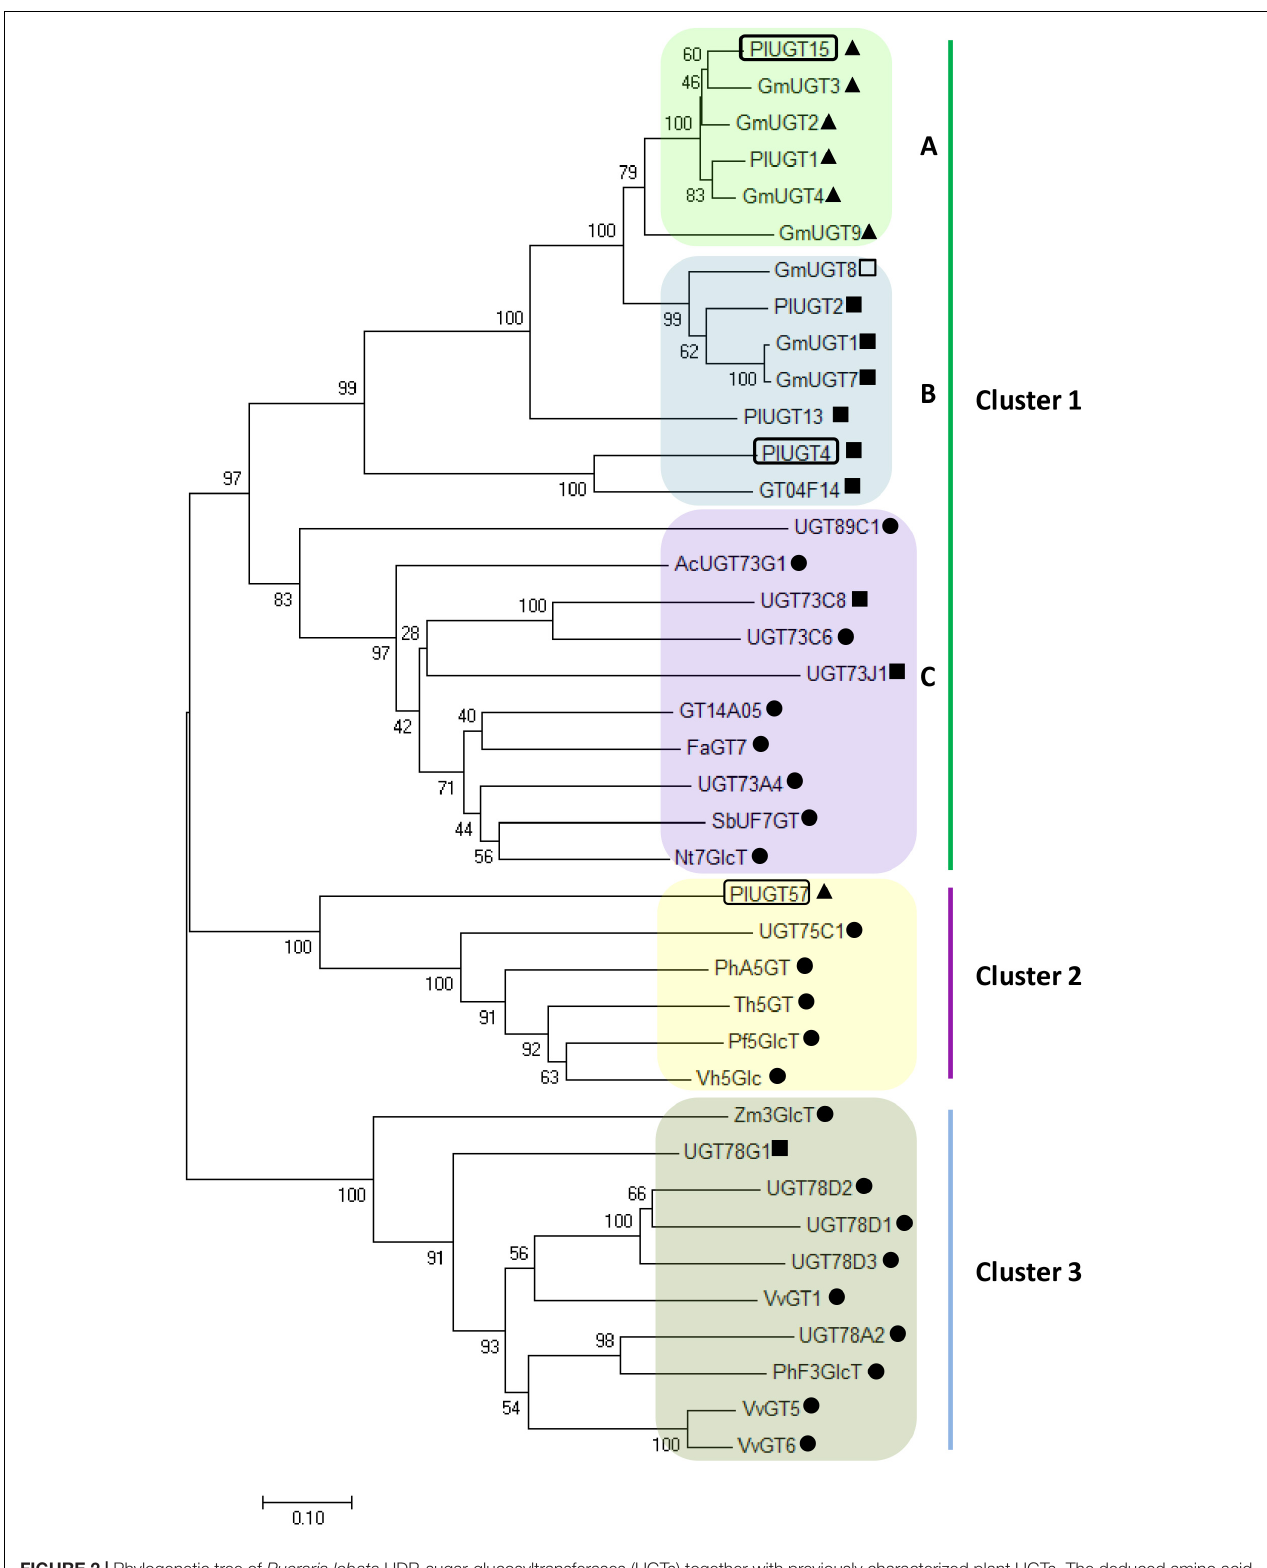
FIGURE 2 | Phylogenetic tree of Pueraria lobata UDP-sugar-glucosyltransferases (UGTs) together with previously characterized plant UGTs. The deduced amino acid sequences were aligned by Clustal W and a Neighbor-Joining tree was constructed using MEGA 7.0 software with 1000 bootstrap replicates. The